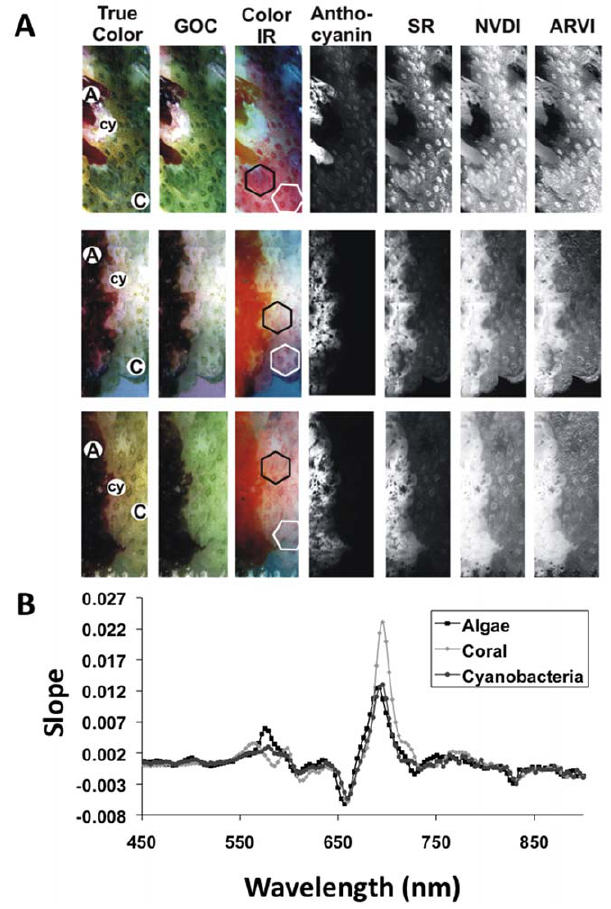
Figure 4. Different renderings of hyperspectral images of the interaction zones between the coral Pocillopora sp.and red alga Gracilaria sp. A) The location of algae ( A ), coral ( C ) and cyanobacteria ( cy ) are indicated in the True Color image. The color coding is determined for True Color using the three bands red (640 nm), green (550 nm), and blue (460 nm); GOC using the three bands green (515 nm), orange (575 nm), and chlorophyll (685 nm); Color IR using the three bands green (550 nm), red (650 nm), and infrared (IR; 860 nm); SR (Simple Ratio) using the ration between 800 nm and 680 nm; NVDI (Normalized Vegetative Density Index) using IR (800 nm) and red (680 nm) in the formula (IR 2 red)/(IR + red); and ARVI (Atmospherically Resistant Vegetative Index) using the bands IR (800 nm), red (680 nm), and blue (450 nm) entered in the formula (IR 2 2*red + blue)/(IR + 2*red 2 blue). Each rendering uses a 2% Stretch Contrast Enhancement. B) The slope of the average relative reflectance for the algae, coral, and cyanobacteria imaged in A. Areas used to determine the average reflectance are indicated by hexagons in the IR rendering.